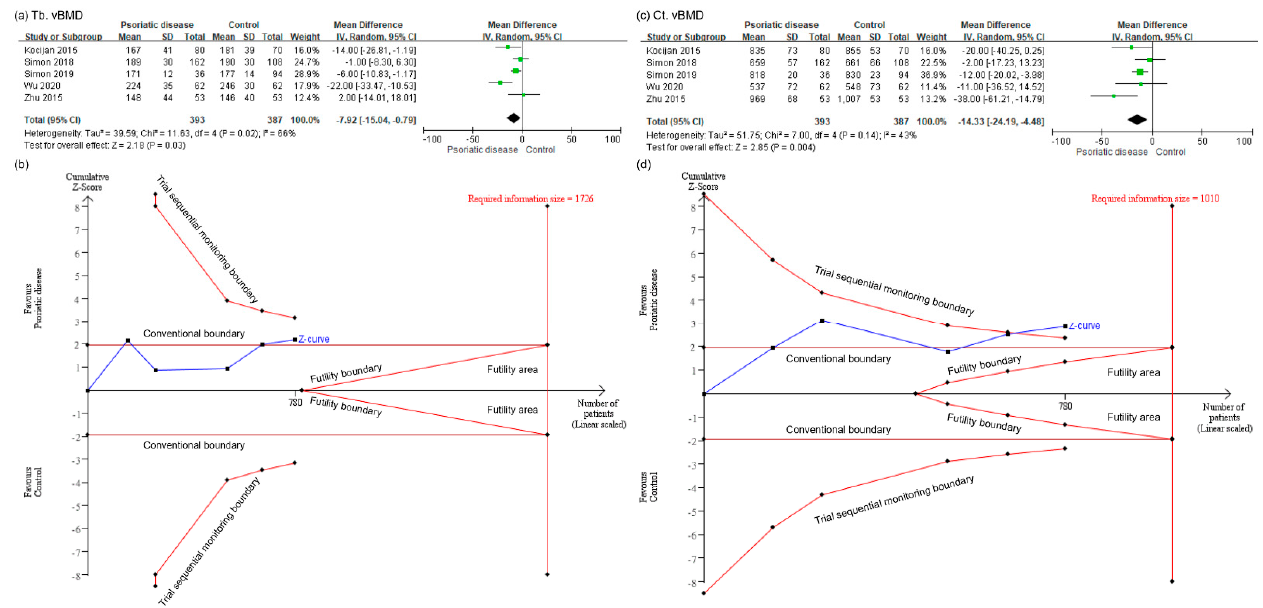
Figure 3. ( a ) meta-analysis of the mean difference in trabecular volumetric bone mineral density (vBMD) in psoriatic patients and controls. ( b ) trial sequential analysis of trabecular vBMD. ( c ) meta-analysis of the mean difference in cortical vBMD in psoriatic patients and controls. ( d ) trial sequential analysis of cortical vBMD. CI, confidence interval; Ct, cortical; IV, inverse variance; SD, standard deviation; Tb, trabecular.